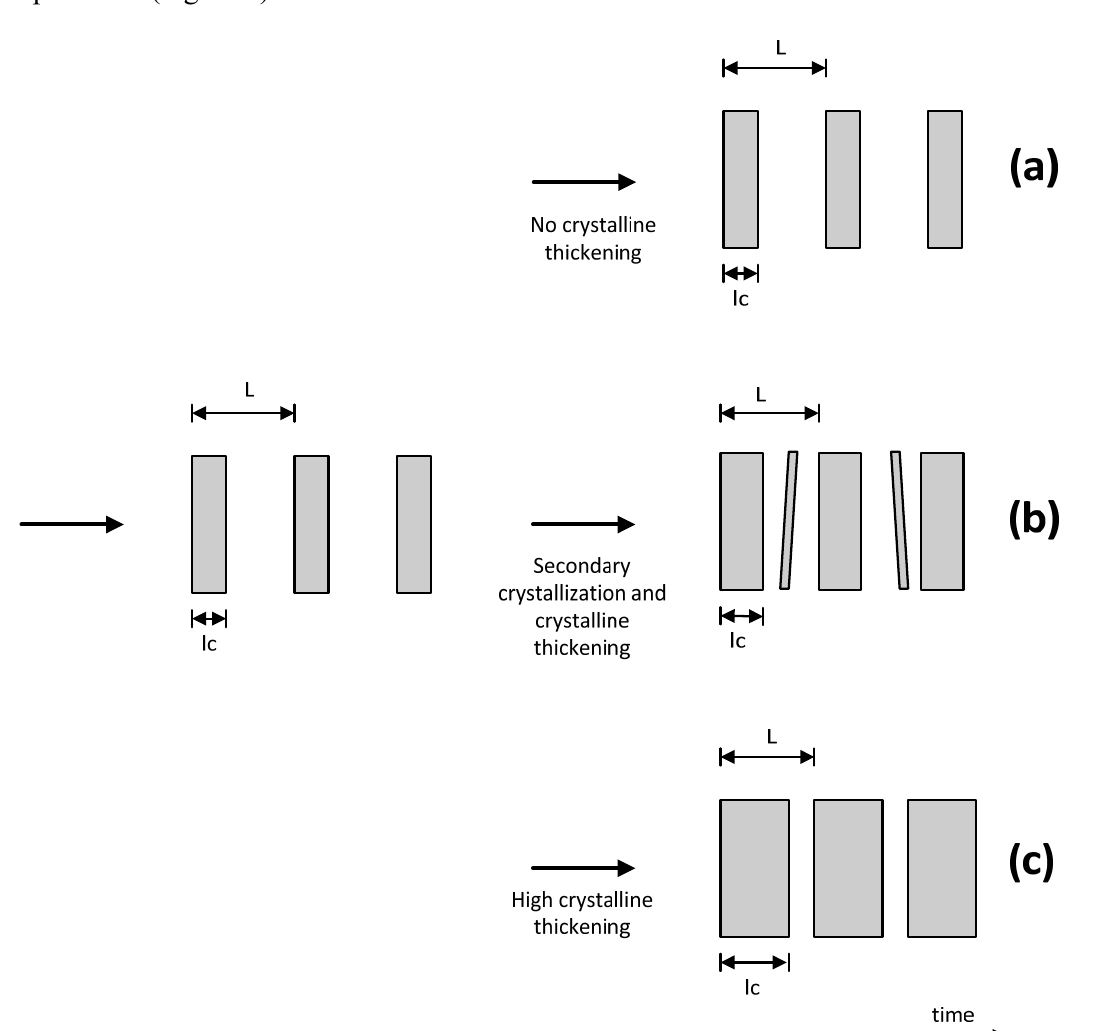
Figure 14. Morphological model for the isothermal crystallization of PET: ( a ) Low temperatures (region 1); ( b ) Intermediate temperatures (region 2); and ( c ) High temperatures (region